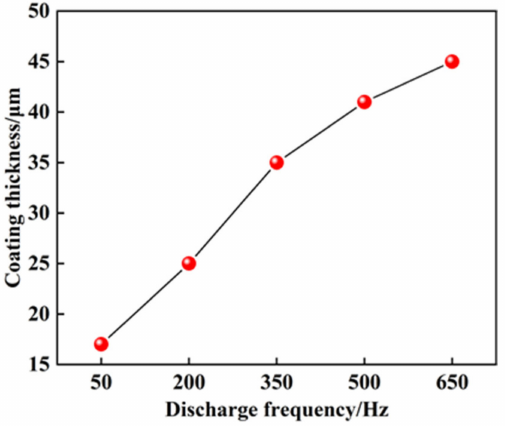
Figure 12. Effect of discharge frequency on the thickness of